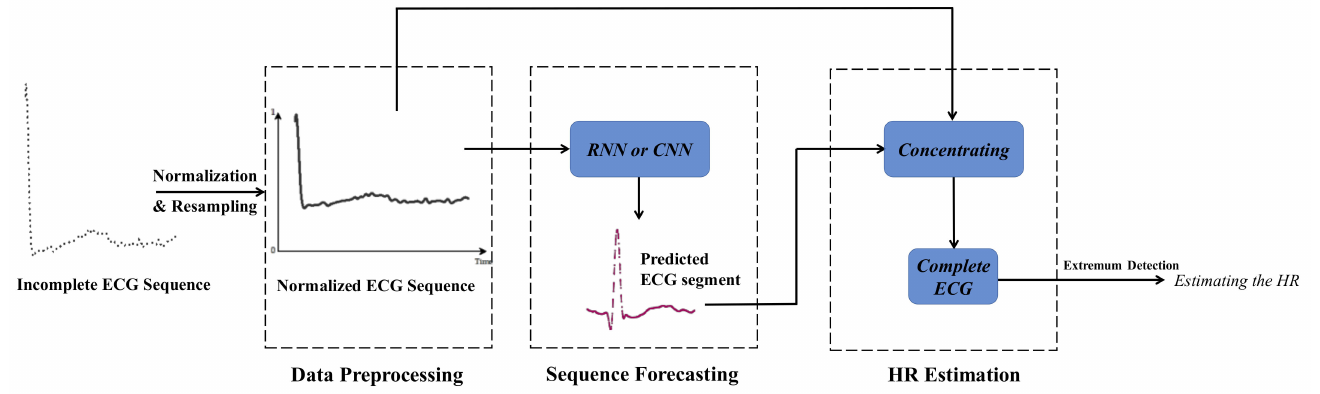
Figure 1. The diagram of the proposed iHR estimation approach employing time-series forecasting with CNN and RNN, and its main three steps: data preprocessing, sequence forecasting, and HR estimation. Following ECG signal normalization, a pretrained neural network would be able to generate time series for a short period of time in the future. We calculate a complete RRI and estimate HR in advance by combining the restored and original